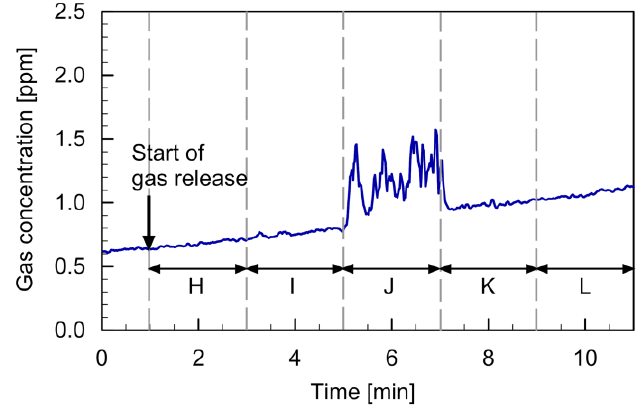
Figure 10. Time course of the PID reading observed when the gas source was moved from point H to point L.